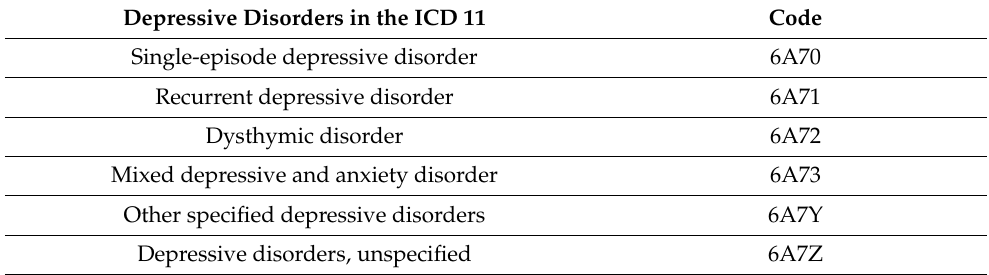
Table 2. Depressive disorders in the ICD